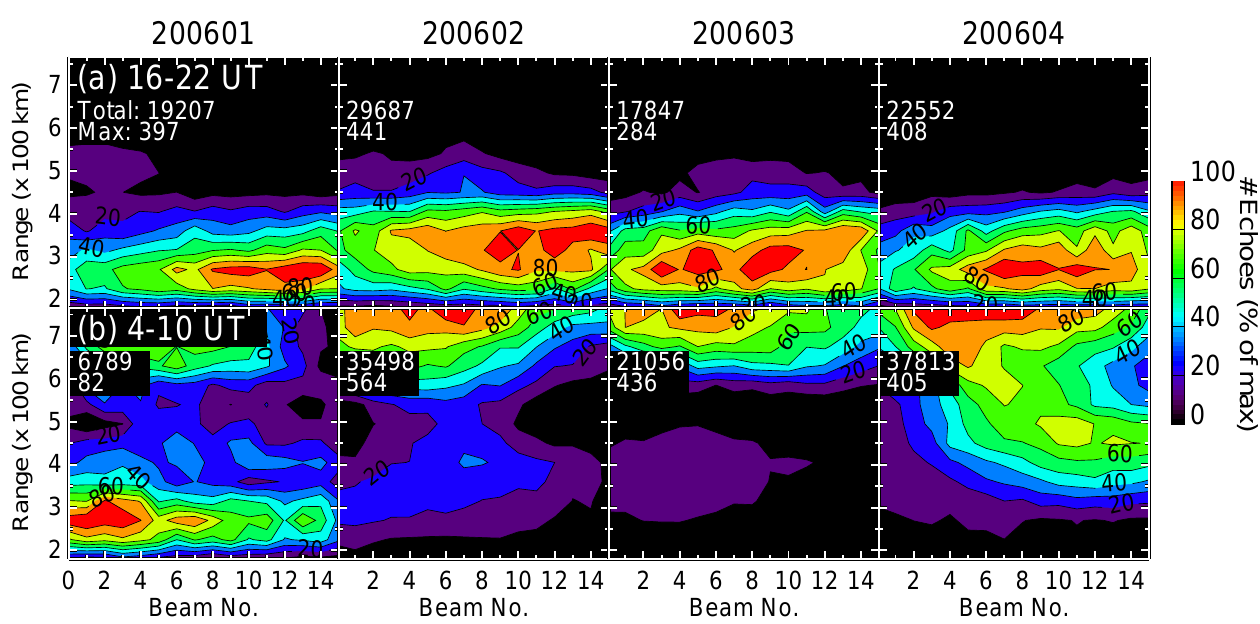
Fig. 4. Normalised spatial distribution of short-range echoes as observed by the Unwin radar. Panel (a) shows the spatial distribution for the morning sector (16:00–22:00UT) in January–April 2006. Panel (b) is the same as panel (a), but for the evening sector (04:00–10:00UT). The total number of points included in each plot is indicated in the top-left corner along with the maximum value of occurrence. The colour scale is shown on the